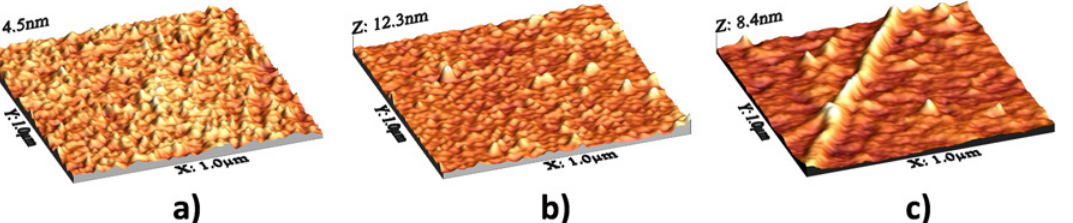
Fig 2. Atomic force microscopy. 3D rendering of: a gold coated Si substrate a) before and b) after functionalization with lipoic acid, and c) after additional subsequent functionalization with butyric acid and pOBP. Note that a different Z scale was used for the three images.